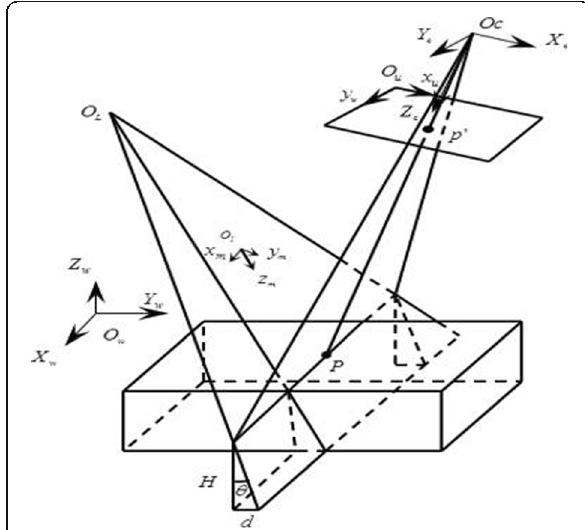
Fig. 12 3D measurement model about the single line-structured light mode